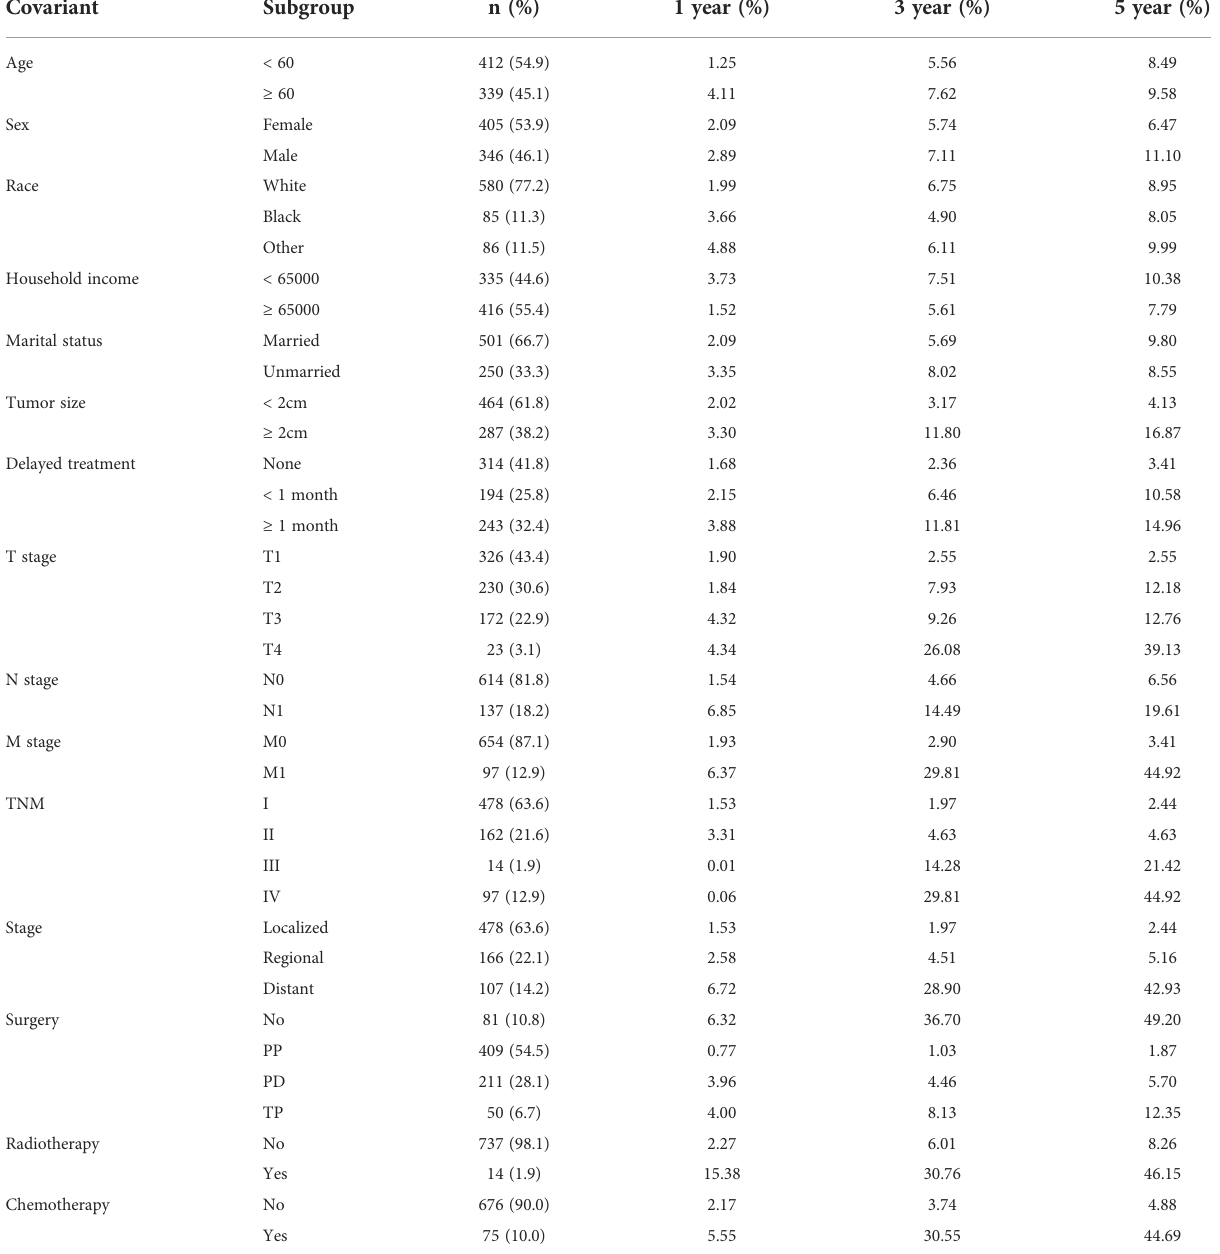
TABLE 3 Cumulative incidence of CSS in 1, 3 and 5 year among different subgroups for G1 pNETs survivors. Covariant Subgroup n